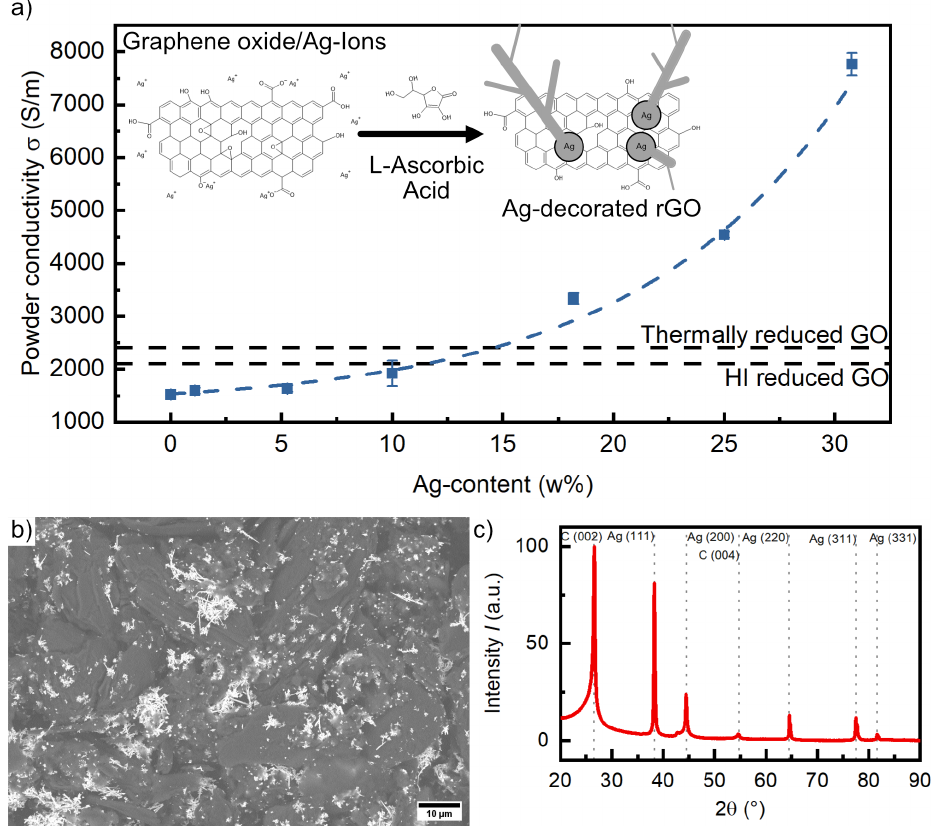
Figure 5. Preliminary results of the Ag + and graphene oxide co-reduction by L-Ascorbic acid: ( a ) powder conductivity of Ag/rGO powders against the Ag content (Insert: reaction scheme); ( b ) SEM micrograph showing dendritic Ag particles deposited on rGO flakes; ( c ) X-ray diffractogram of a rGO/Ag powder showing no sign of